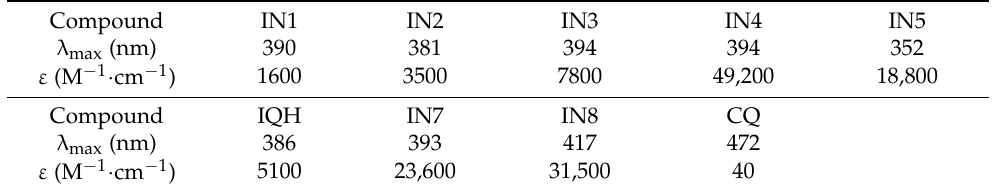
Table 3. Optical characteristics of IN1-IN5, IQH, IN7, IN8 and camphorquinone (CQ) in ethanol.